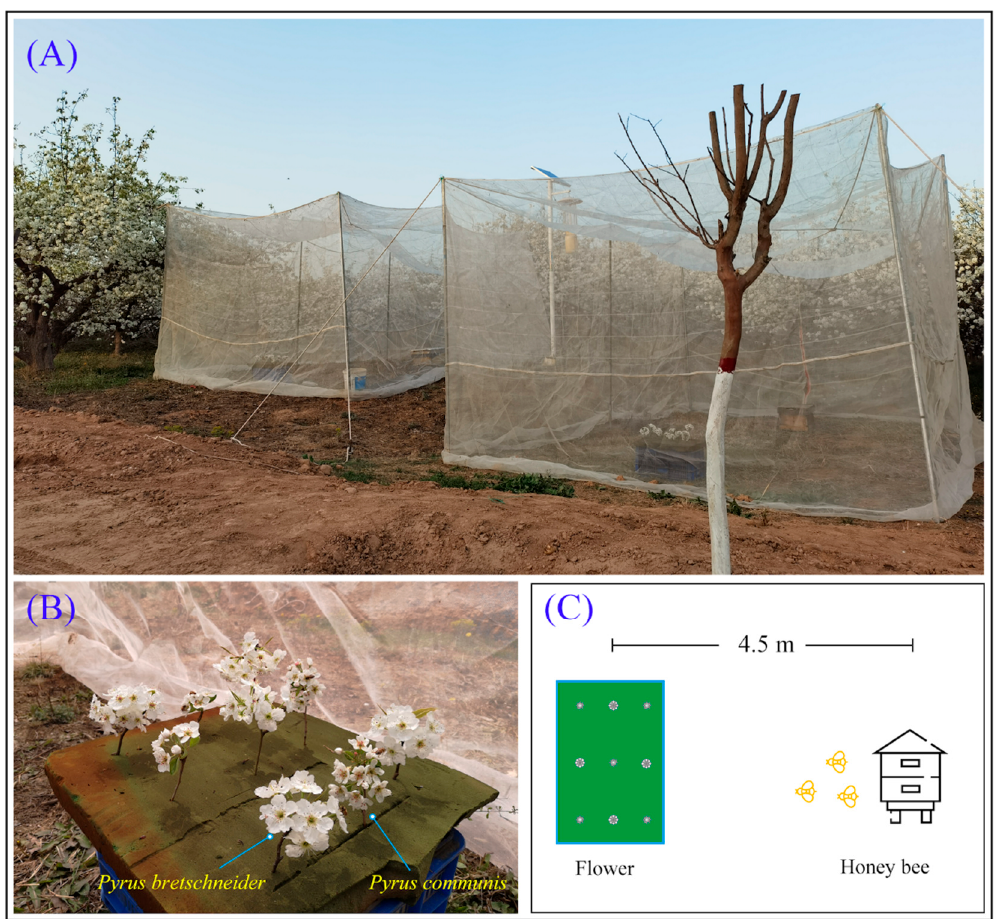
Figure 1. Behavioral observation experiment. ( A ) Flight cages; ( B ) flowers of P. bretschneideri and P. communis ; ( C ) schematic setup of pear flowers and honey bees in the flight